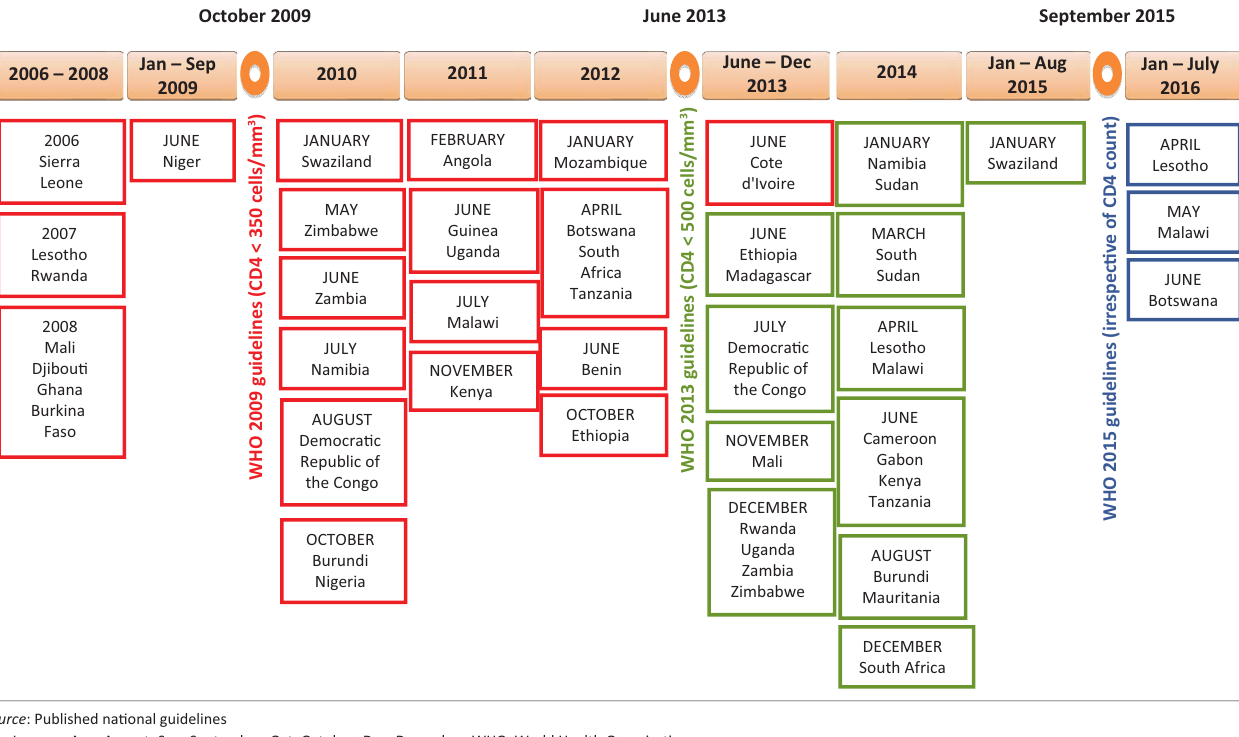
FIGURE 2: Timeline showing the date of release of the WHO guidelines and national guidelines from 33 countries in sub-Saharan Africa (January 2006–August